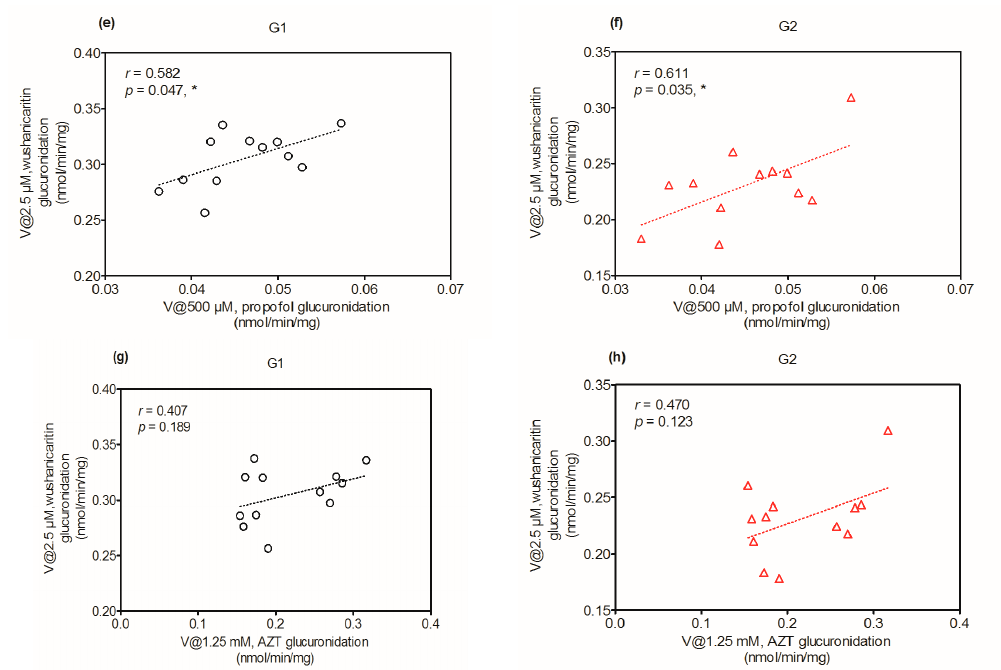
Figure 5. Correlation analysis between wushanicaritin 3- O -glucuronidation and β -estradiol glucuronidation ( a ), wushanicaritin 7- O -glucuronidation and β -estradiol glucuronidation ( b ) in a bank of individual human liver microsomes ( n = 12); wushanicaritin 3- O -glucuronidation and CDCA glucuronidation ( c ), wushanicaritin 7- O -glucuronidation and CDCA glucuronidation ( d ) in a bank of individual human liver microsomes ( n = 12); correlation analysis between wushanicaritin 3- O -glucuronidation and propofol glucuronidation ( e ), wushanicaritin 7- O -glucuronidation and propofol glucuronidation ( f ) in a bank of individual human liver microsomes ( n = 12); correlation analysis between wushanicaritin 3- O -glucuronidation and AZT glucuronidation ( g ), wushanicaritin 7- O -glucuronidation and AZT glucuronidation ( h ) in a bank of individual human liver microsomes ( n = 12). All experiments were performed in triplicate. CDCA: chenodeoxycholic acid; AZT: zidovudine. G1: wushanicaritin-3- O -glucuronide; G2: wushanicaritin-7- O -glucuronide.